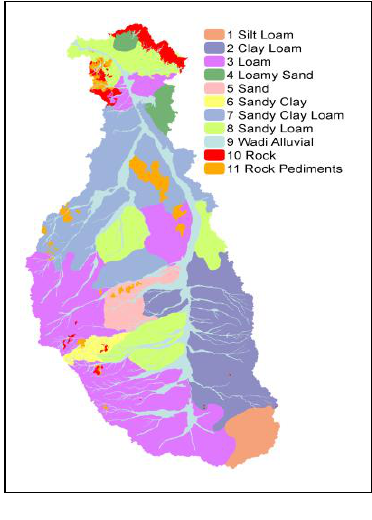
Soil map of Wadi El Hawad